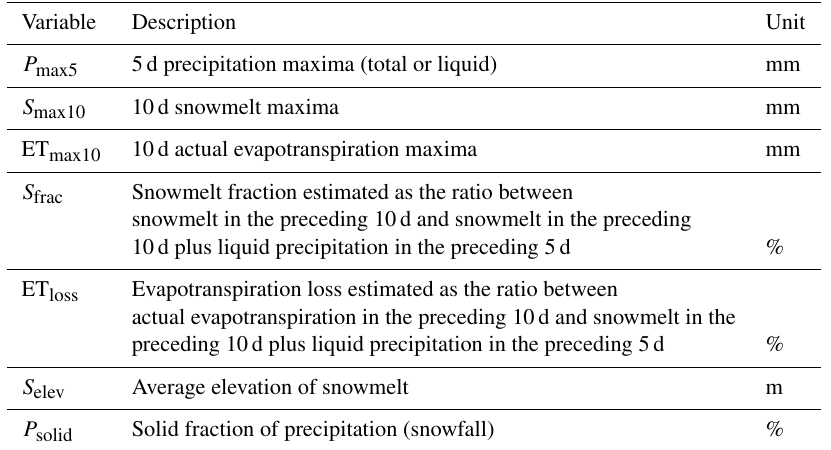
Figure 3. Scheme of the analytical set-up depicting gauges (Basel, Cochem and Cologne) and sub-basins (at the gauges at Basel and Cochem) investigated in detail. Table 2. Names/abbreviations, descriptions and units of variables investigated on sub-basin